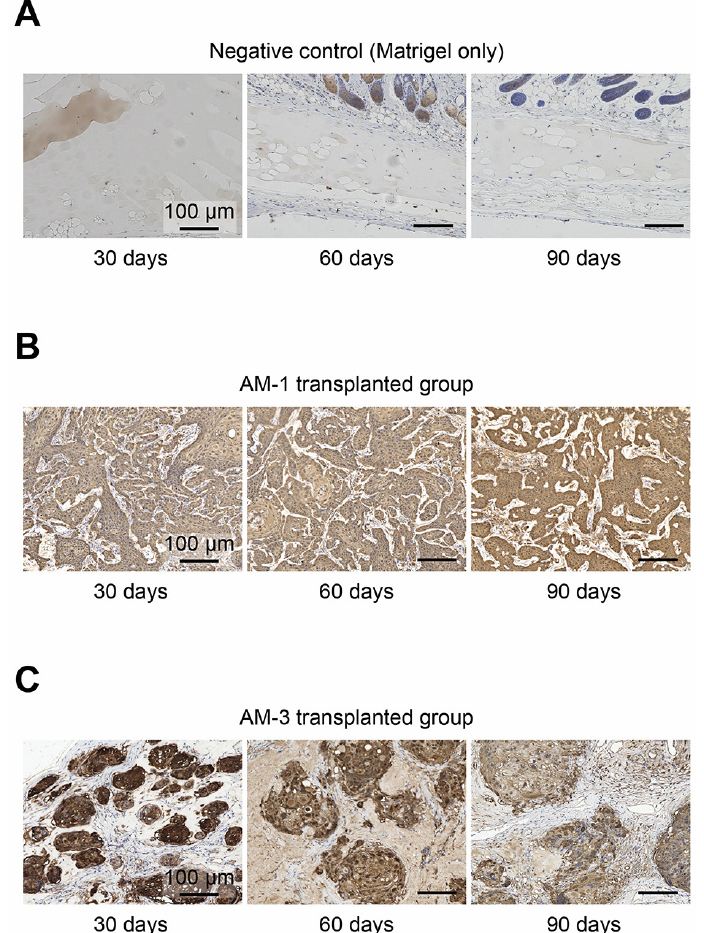
Figure 3- Histological images of the immunohistochemistry using the GFP antibody at each time point: 30, 60, and 90 days. (A) Negative control group: transplanted with Matrigel without cells. (B) AM-1 group: transplanted with AM-1 cells with Matrigel. (C) AM-3 group: transplanted with AM-3 cells with Matrigel. Magnification: